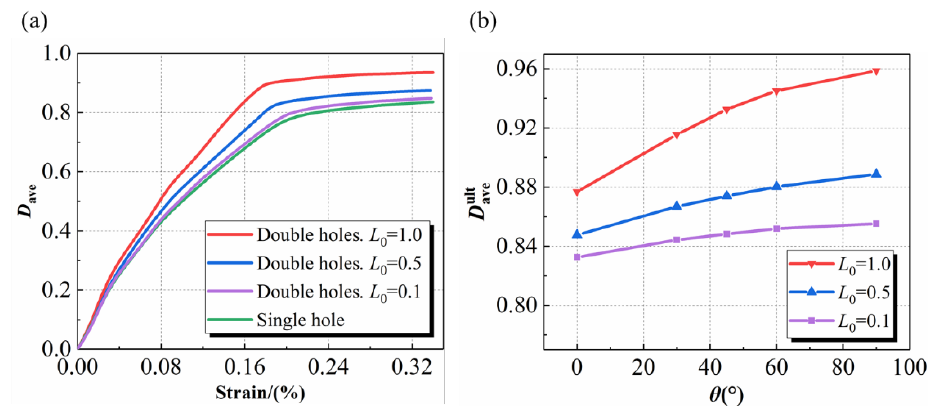
Figure 14. ( a ) Average damage at different L 0 when θ = 45° ( b ) the variation law of the damage ultimate value with the angle θ .